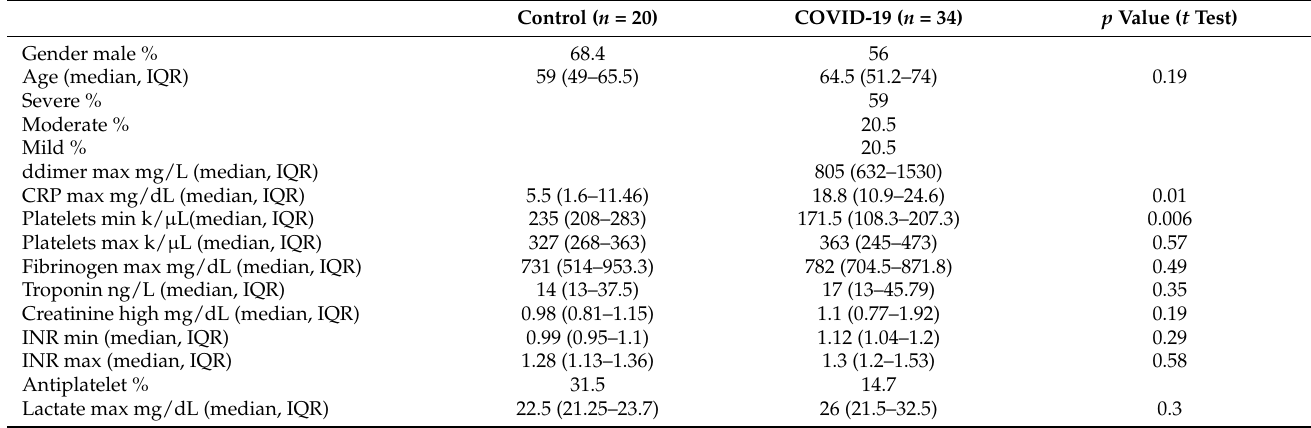
Table 1. Clinical and demographic characteristics of the patients who participated in the